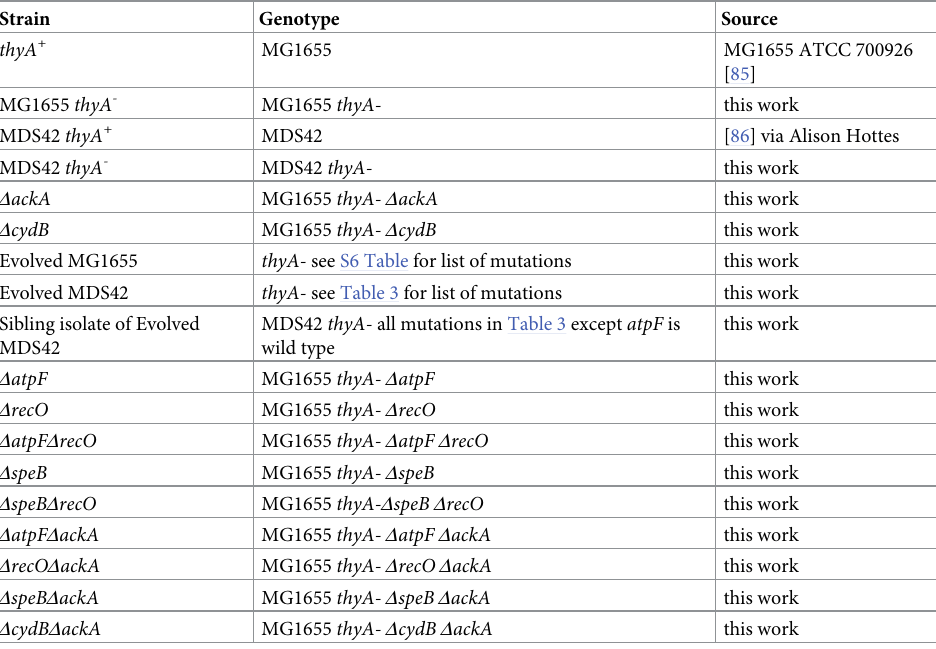
Table 5. Strains used in this work.